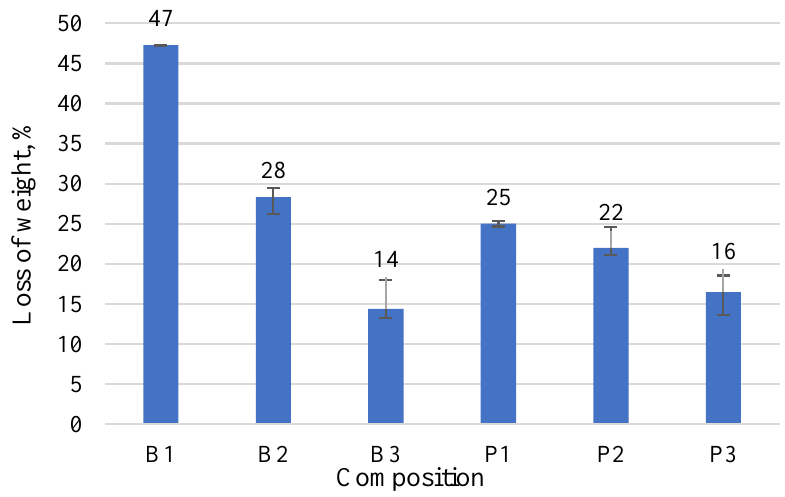
Figure 5. Loss of weight to initial weight. B1 to B3—samples with different amounts of commercial gypsum, P1 to P3—samples with different amounts of phosphogypsum.